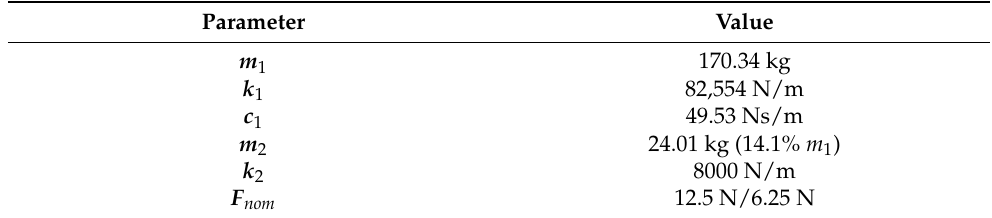
Figure 1. Two-body diagram of a regarded system with an H-MR-TVA. Table 1. The adopted system parameters.